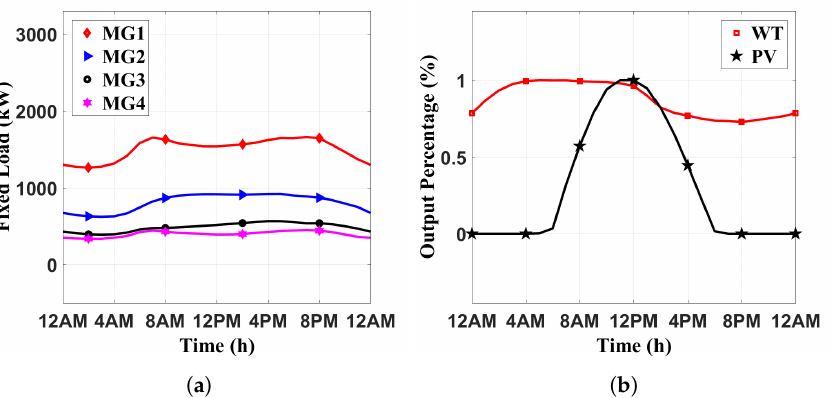
Figure 5. ( a ) Fixed load profile of the different MGs and ( b ) daily forecasted curve of output percentage of solar and wind